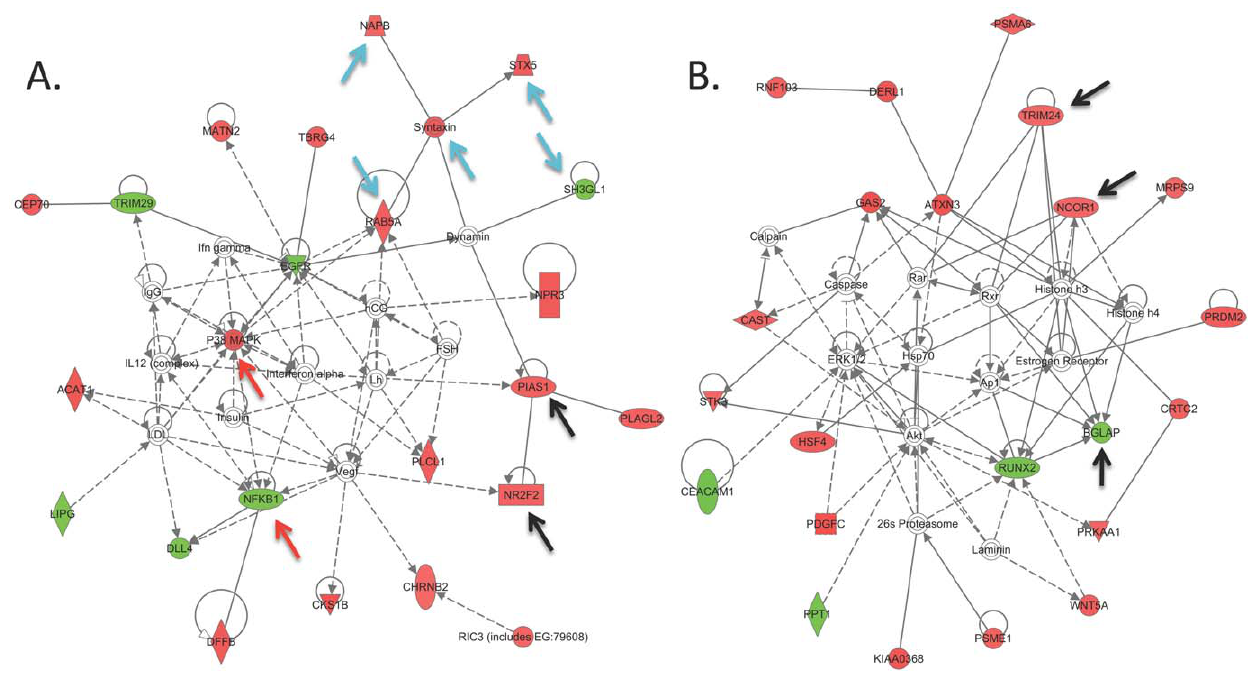
Figure 6. Genetic network analysis of brain gene expression correlating with basal cerebral cortical DOC levels across BXD strains. Genetic correlations (Pearson’s r ) between whole brain gene expression and basal cerebral cortical DOC levels were generated within GeneNetwork (www.genenetwork.org). A total of 458 genes (496 probesets) had r values of p , 0.001 (Table S6). Gene networks were generated from this DOC gene set by Ingenuity Pathway Analysis. The top two scoring networks are portrayed. All colored gene symbols were contained within the DOC-correlated gene set with either positive (red) or negative (green) expression correlations with DOC across 20 BXD lines. Arrows indicate representative genes functioning in nuclear receptor action (black), inflammation (red), or vesicular trafficking and synaptic transmission (blue).